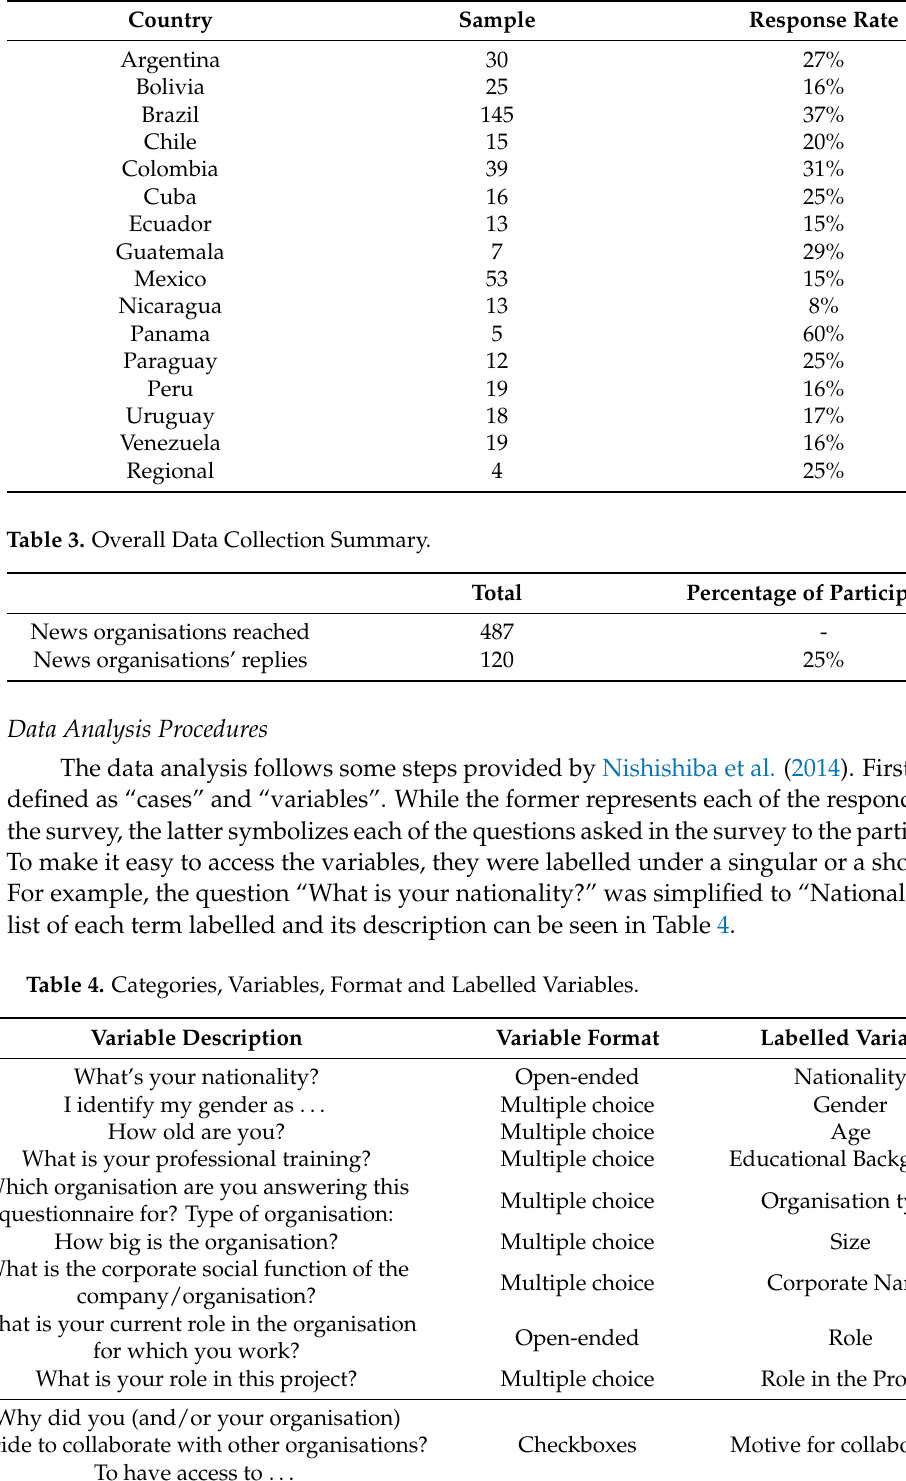
Table 2. Nationality.